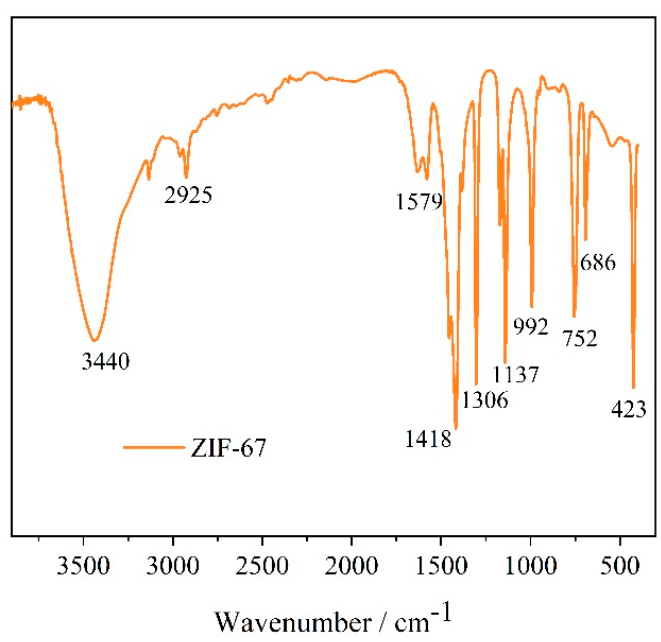
Figure 5. The IR spectrogram.